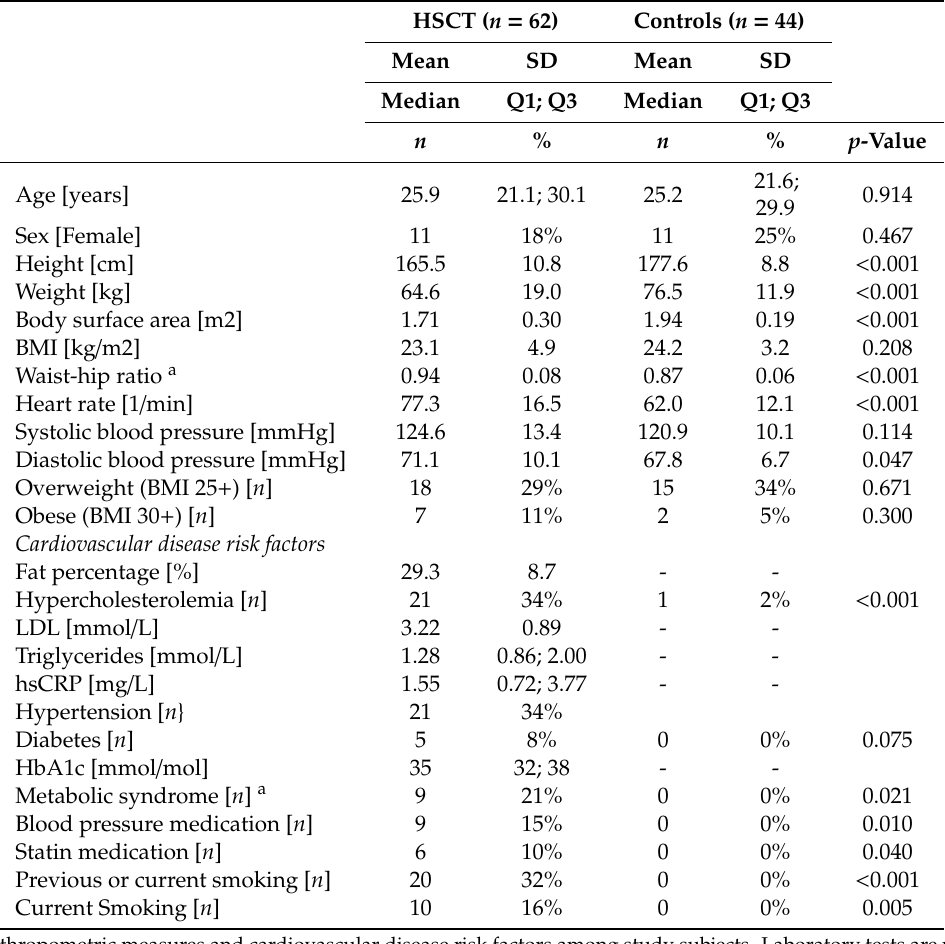
Table 1. Study subject characteristics at